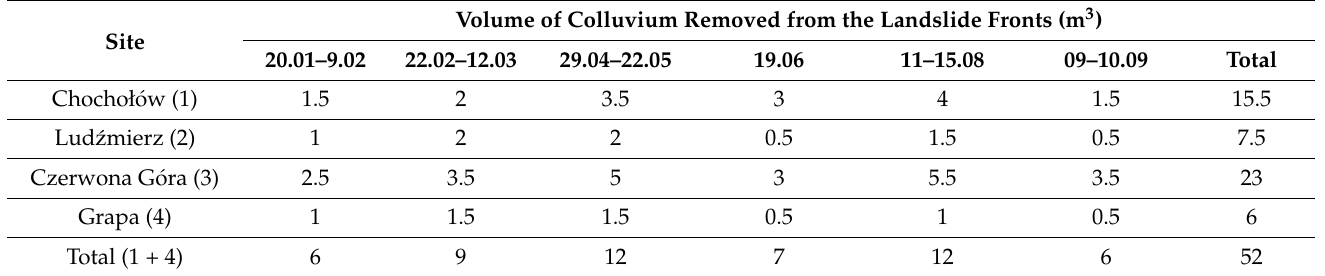
Table 3. Volumes of colluvium eroded from the studied landslides in 2019.